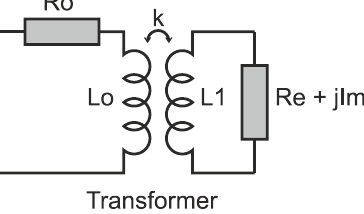
Figure 4. Model of coil-target interaction based on a transformer (adapted from